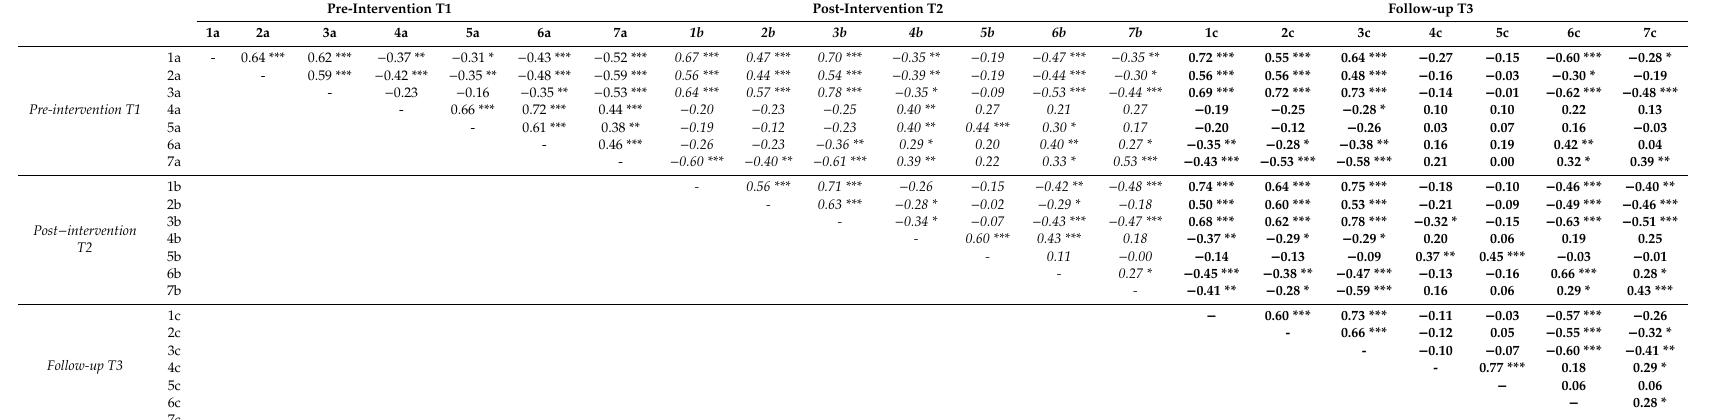
Table 3. Bivariate Pearson correlations among study variables for participants ( n = 55) at pre-intervention (T1), post-intervention (T2) and follow-up